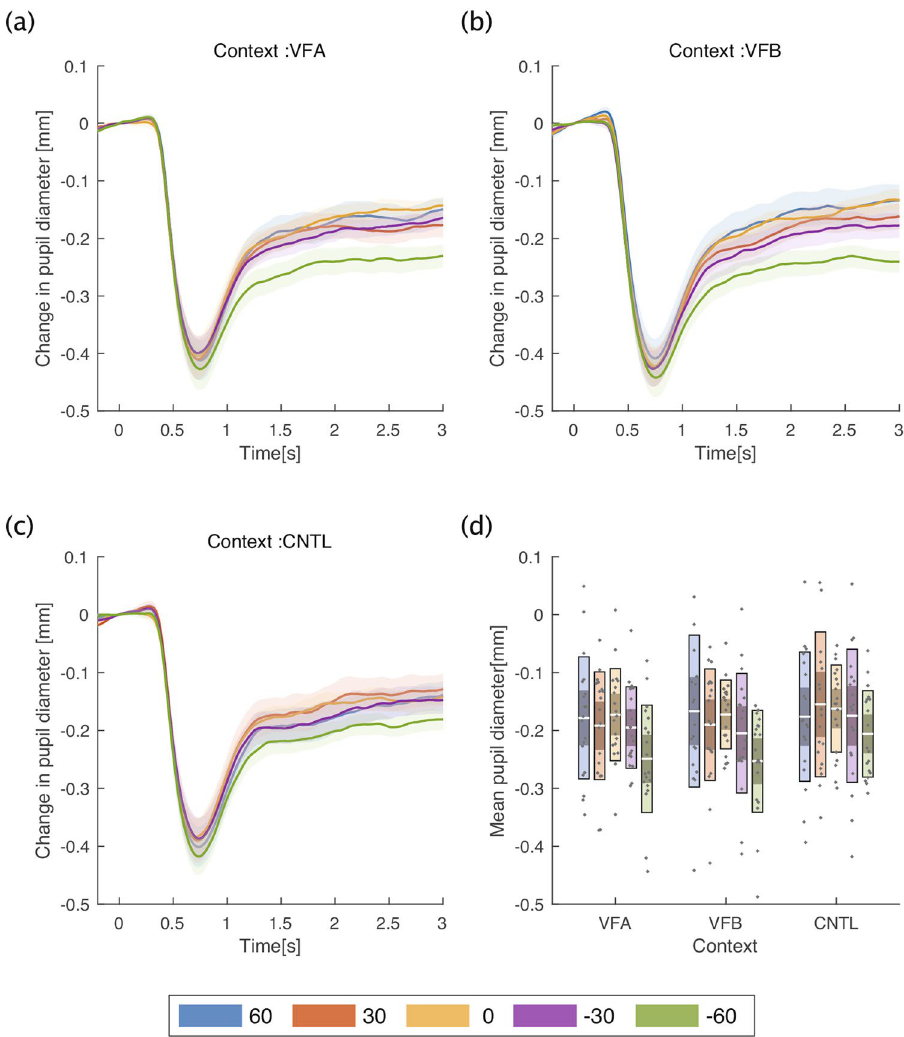
Figure 6. Pupillary results in Experiment 2. ( a ) Time course of average pupil diameter in the viewed from above (VFA) context across all participants. ( b ) Time course of average pupil diameter in the viewed from below (VFB) context across all participants. ( c ) Time course of average pupil diameter with the control context across all participants. ( d ) Average pupil diameter from one to three seconds for each context in the vertical condition. In ( a,b ), the line shows the average pupil diameter, and the shaded color shows the standard error of the mean (SEM). In ( c ), the white line indicates the mean of participants, the light color indicates 1.96 SEM (95% confidence interval), the dark color indicates one standard deviation, and each gray dot indicates the mean of each participant. Each color represents the angle at which the stimulus was